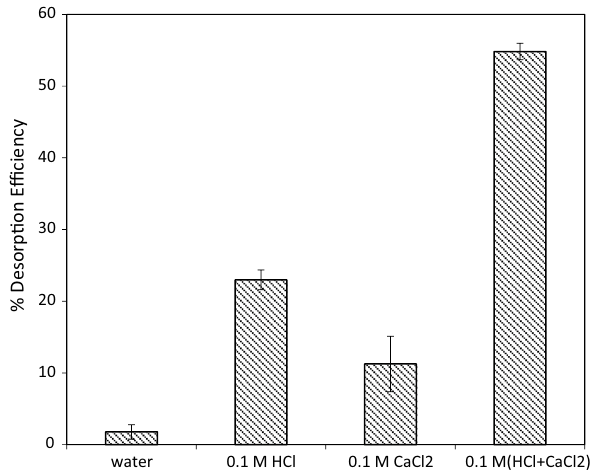
Fig. 8 Desorption studies of laden biochar DSB550-3 with Pb 2+